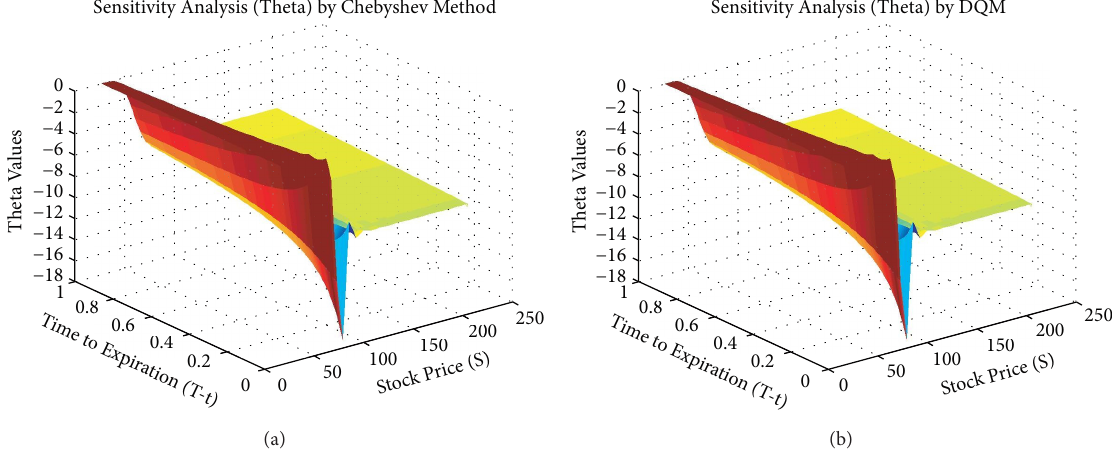
Figure 17: Sensitivity analysis (theta) by Chebyshev spectral method (a) and by differential quadrature method